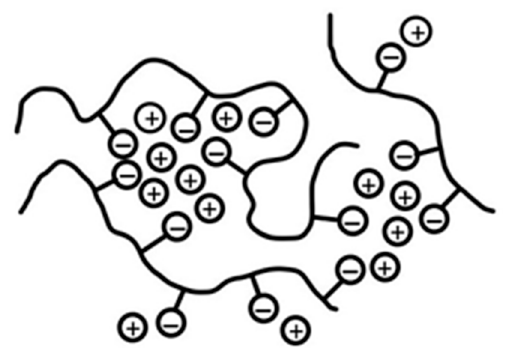
Figure 1. Schematic diagram of an ionomer showing crosslinks formed by ionic clusters in a polyanion with associated cations.